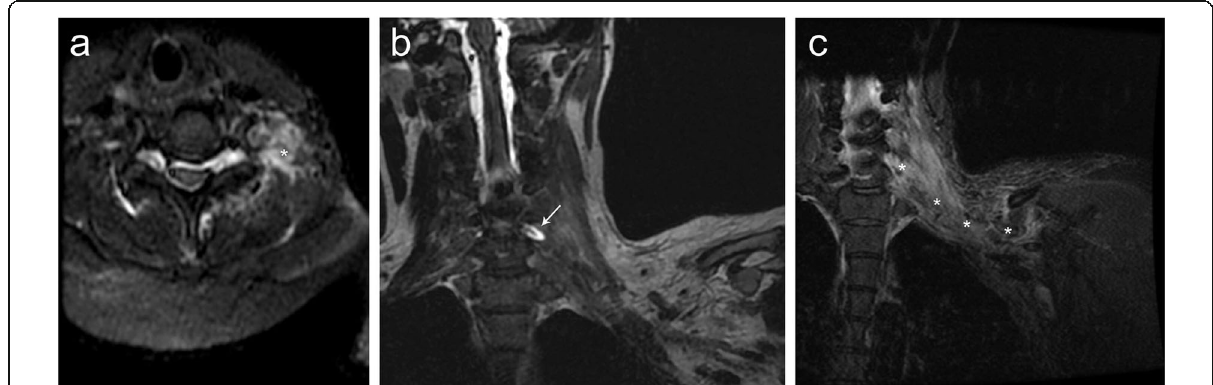
Fig. 11 Traction injury of the brachial plexus. Patient with acute traumatic left C7 nerve root avulsion secondary to traction injury of the brachial plexus. Axial ( a ) short tau inversion recover (STIR) MR images demonstrate increased signal (asterisk) of the left neck base consistent with edema of the soft tissues at the site of injury. Coronal ( b ) STIR MR image demonstrate a bright signal fluid collection (arrow) which communicates with the cerebral spinal fluid of the spinal cord consistent with posttraumatic pseudomeningocele. Coronal ( c ) STIR MR image of a companion case demonstrating diffuse increased signal (asterisk) of the left neck base and thoracic inlet consistent with edema due to brachial plexus traction